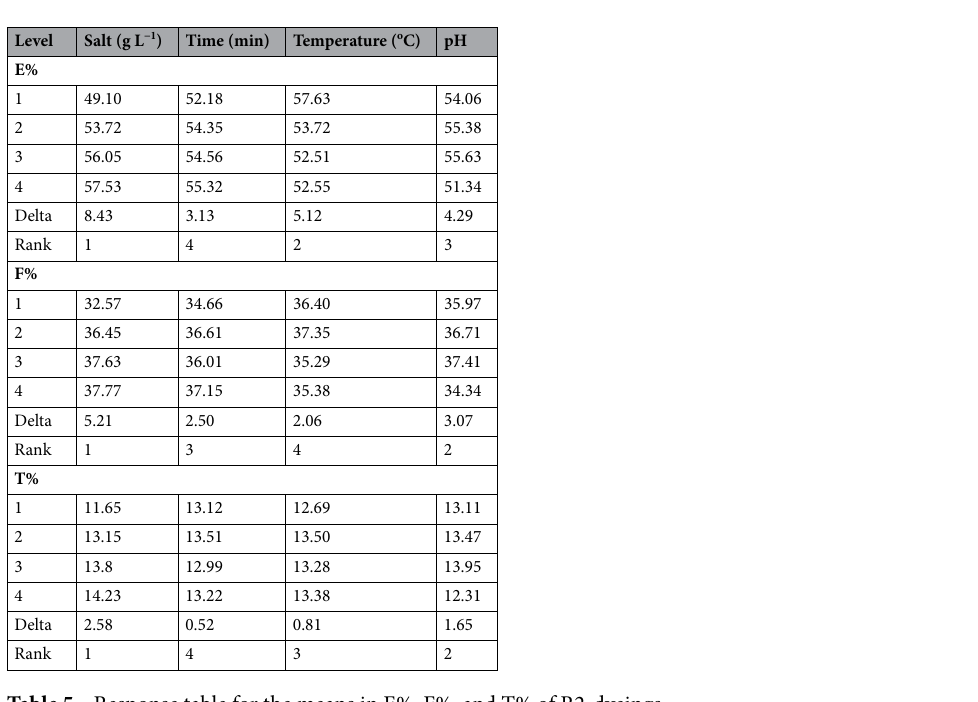
Table 5. Response table for the means in E%, F%, and T% of